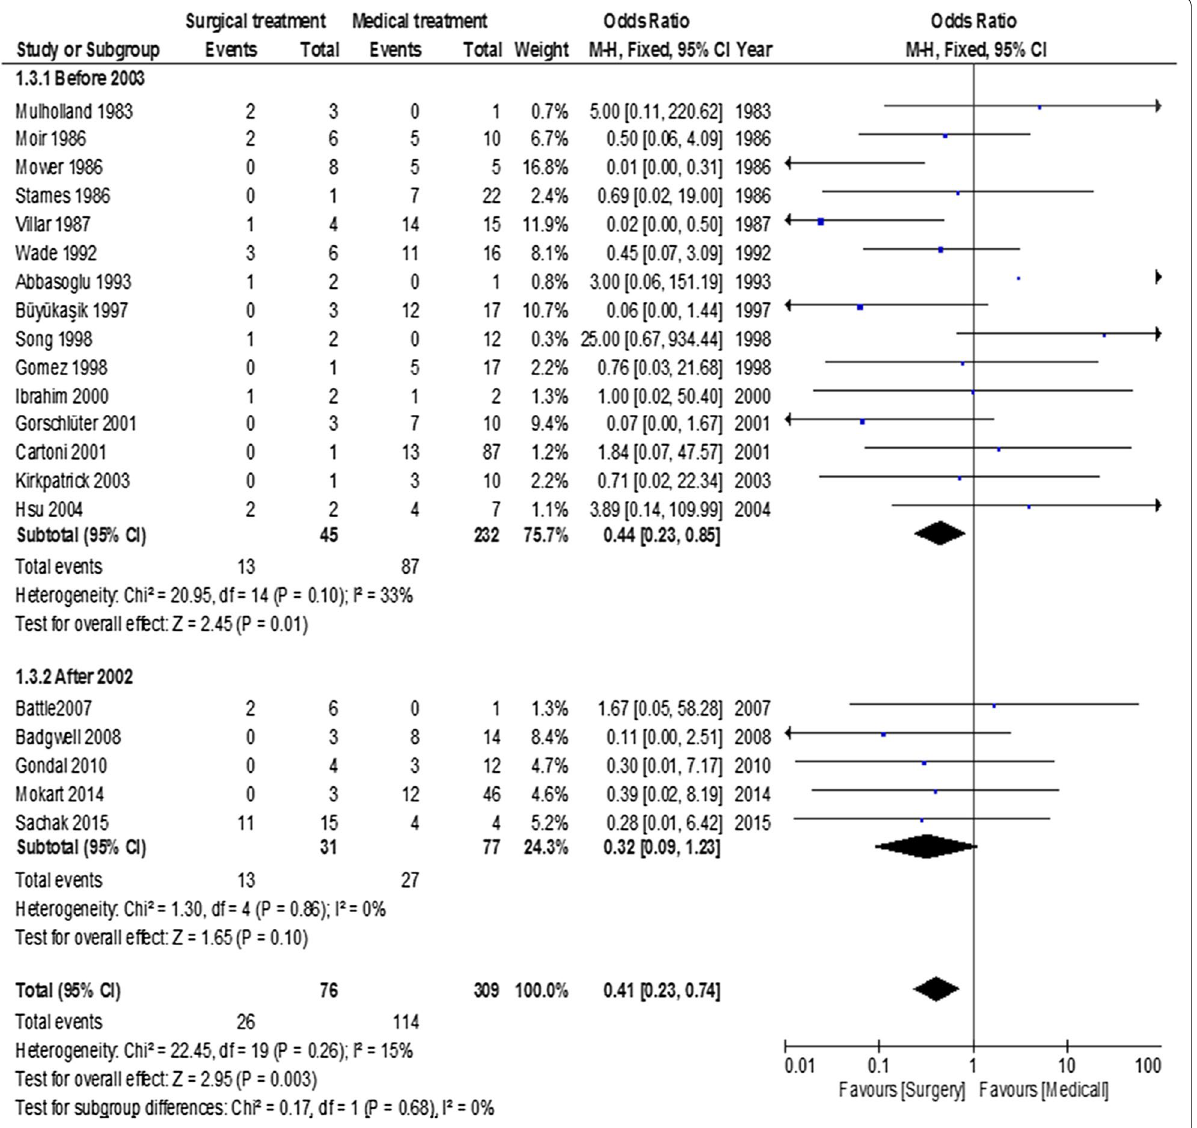
Fig. 4 Summary of odds ratio in included studies according to inclusion